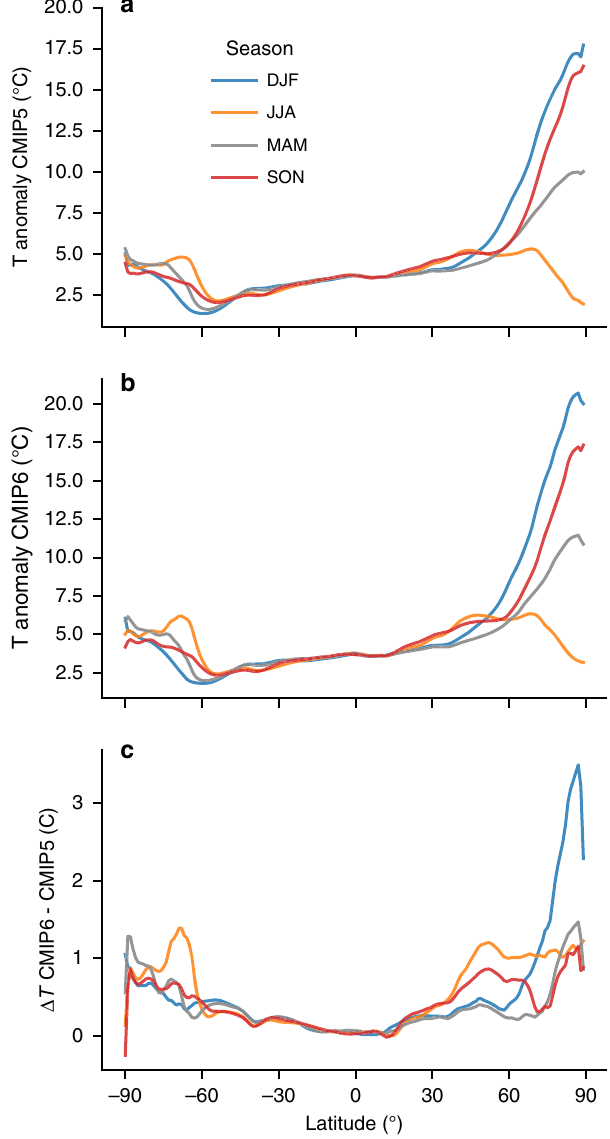
Fig. 2 Seasonality of warming in the CMIP5 and CMIP6 extreme high- emission scenarios. a CMIP5 2 m temperature anomaly (RCP8.5, n = 28) from south to north for the period 2071 – 2100, compared to the baseline climate of 1961 – 1990. Different lines represent the warming in four different seasons. b Same as a but for the CMIP6 SSP585 scenario ( n = 28). c Difference in warming in 2071 – 2100 between CMIP6 (SSP585) and CMIP5 (RCP8.5) (positive = more warming in the SMB in MAR forced by SSP585 models does not show an inherent bias when compared to the MAR RCP8.5 simulations (mean bias: 29.8 mm w.e. (SSP585) compared to 26.3 mm w.e. (RCP8.5)). Therefore, the most likely explanation for greater GrIS surface mass loss is the higher equilibrium climate sensitivity (ECS) in CMIP6 models and a more pronounced Arctic ampli fi cation (Figs. 1 and 2) 30,33 – 35 .